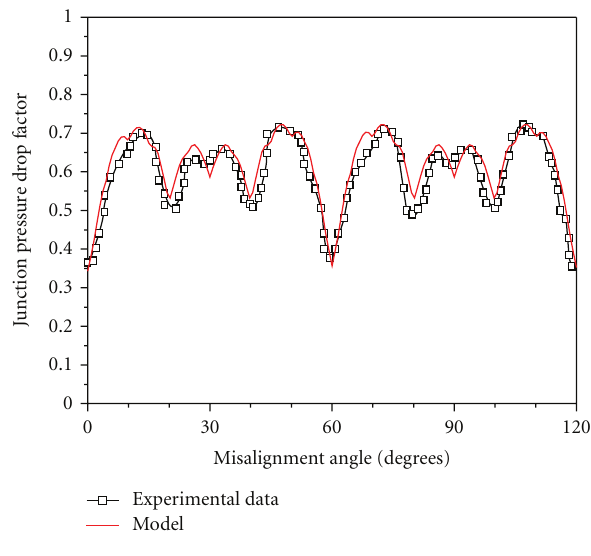
Figure 11: CANDU junction pressure drops.